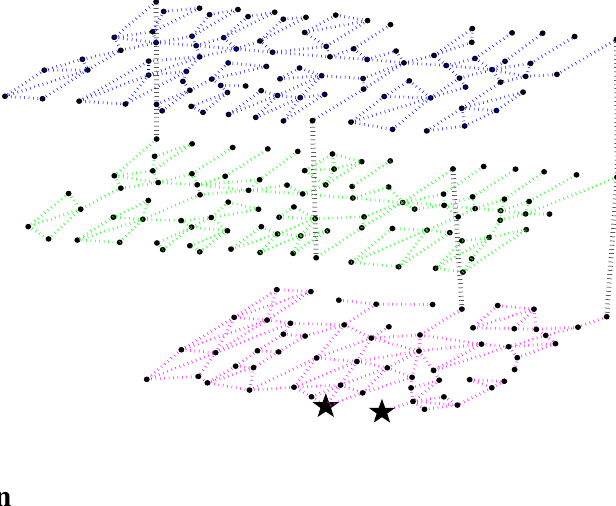
Figure 3. The graph-based layout of the building. The black stars represent the exits on the ground